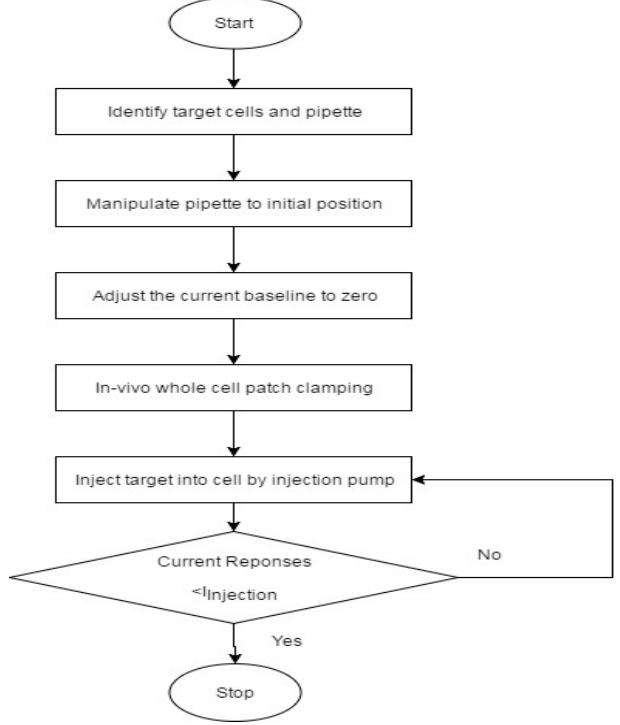
Figure 9. Control strategy of the microinjection system.